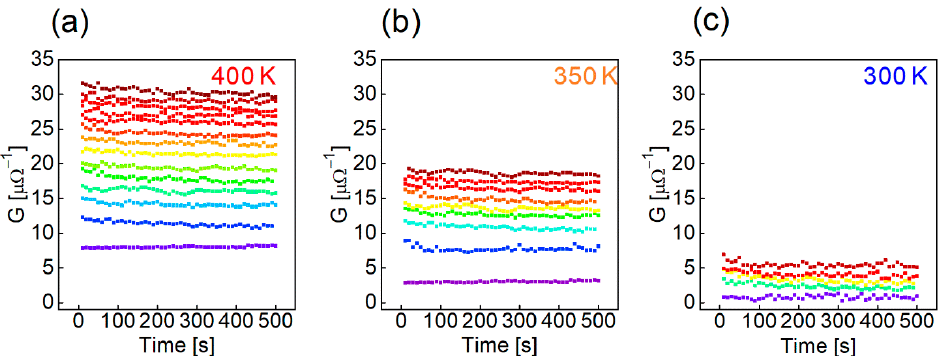
Figure 6. Short retention test of multi-level states in the devices with different annealing temperatures: ( a ) 300 K, ( b ) 350 K, and ( c ) 400 K.